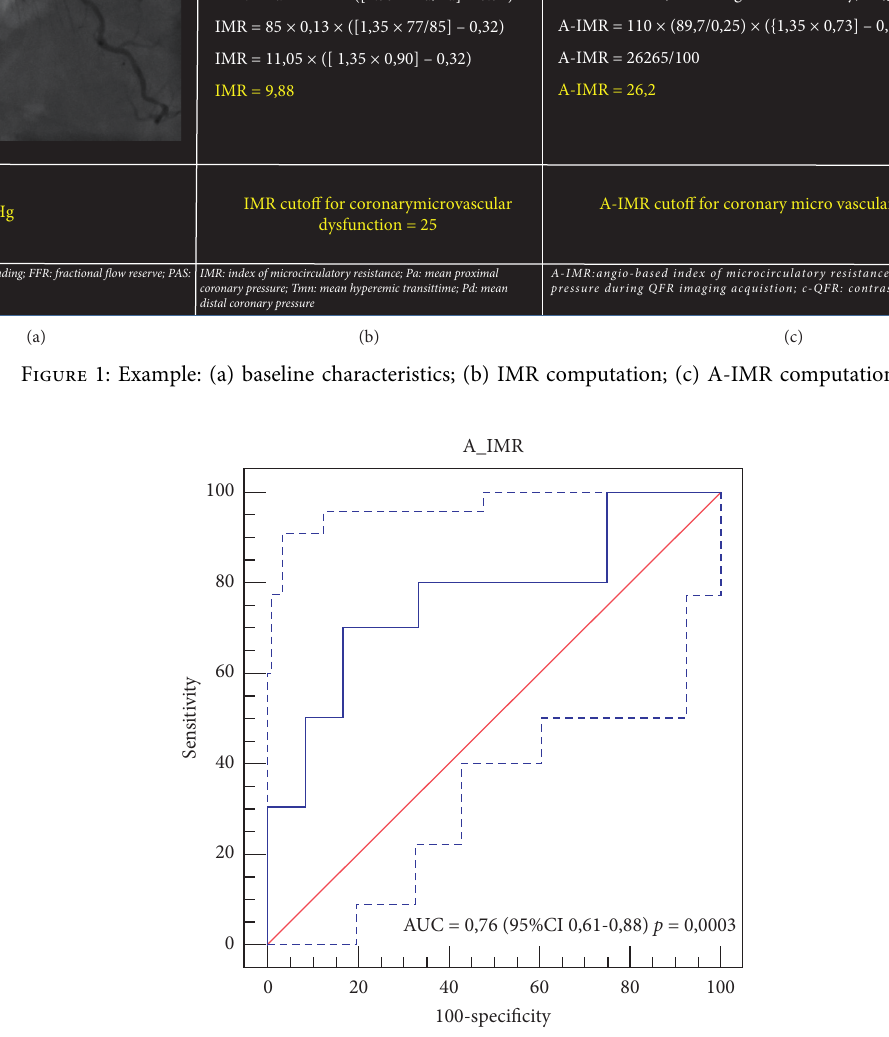
Figure 2: ROC of A-IMR vs.